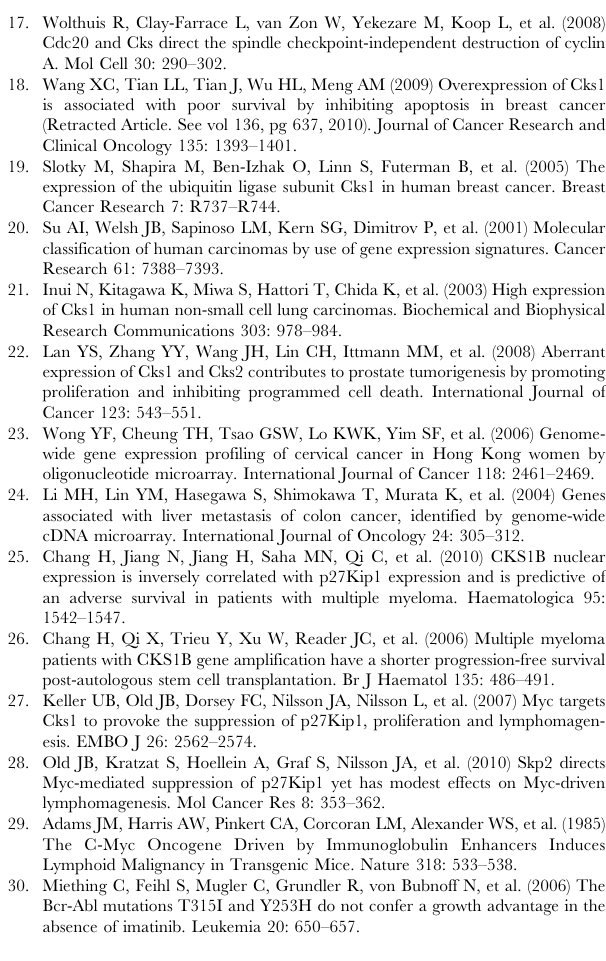
Figure S2 Cks1 expression plasmids used. A , Schematic depiction of the lox-stop-lox plasmid used ( Stop-Cks1-GFP ). The control plasmid used is labeled Stop-GFP in all Figures. B ,